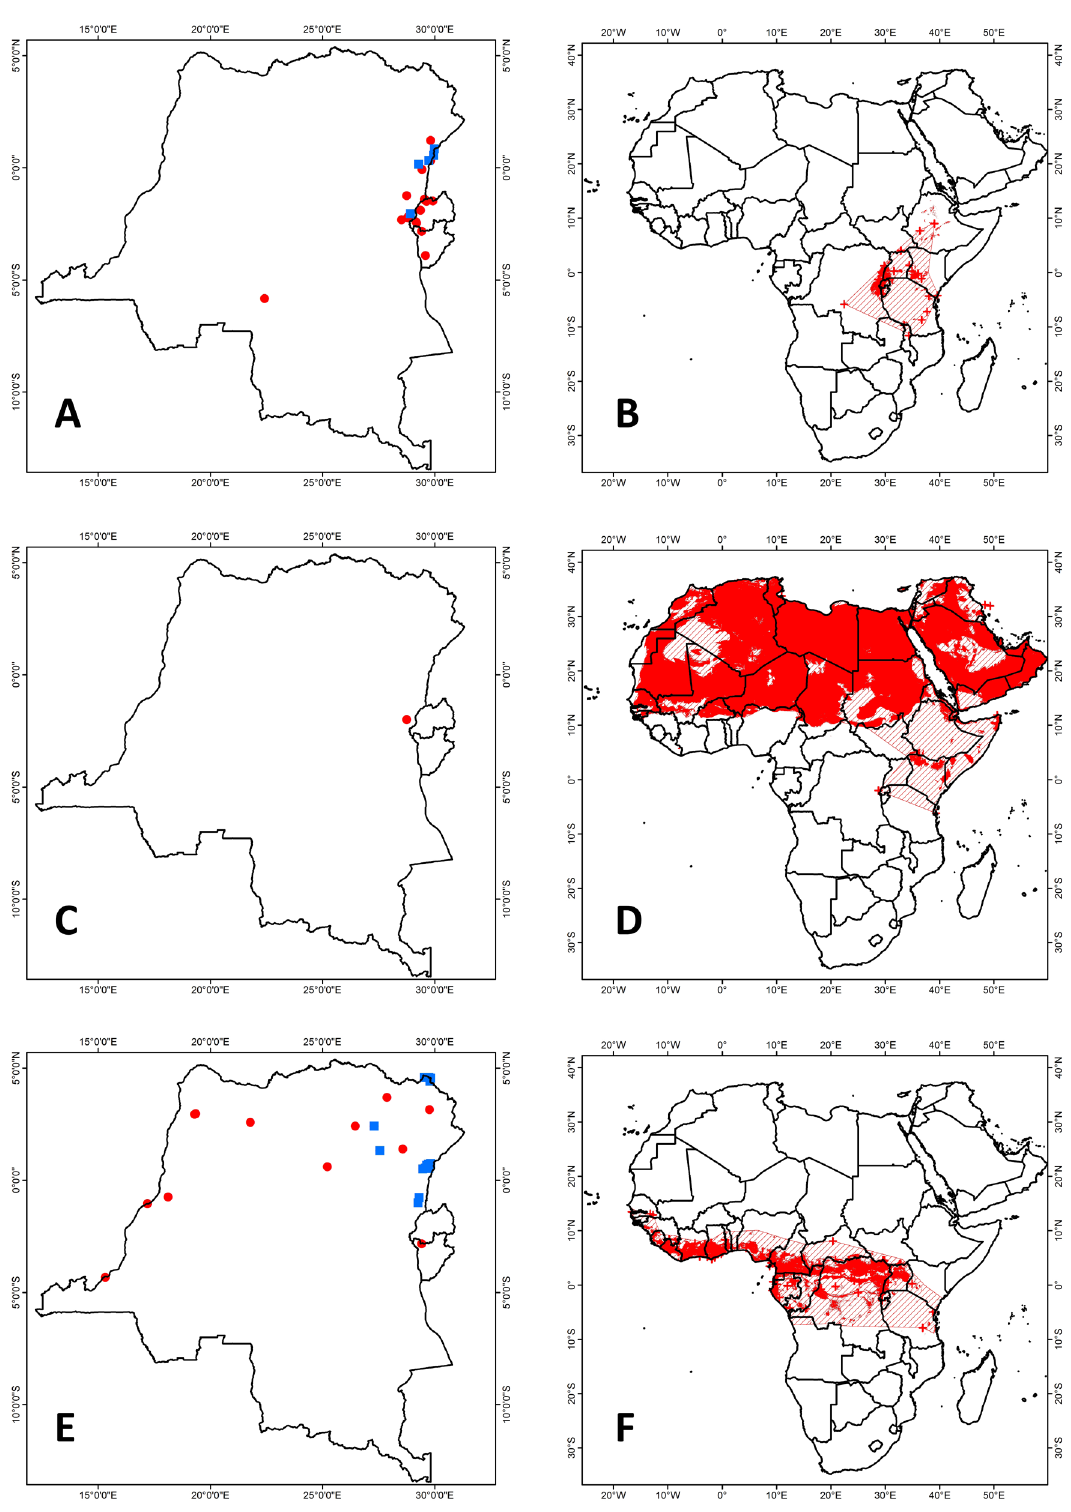
Fig. 10. Distribution maps. A–B . Stenonycteris lanosus Thomas, 1906. C–D . Asellia tridens (E. Geoffroy St.-Hilaire, 1813). E–F . Doryrhina cyclops (Temminck, 1853). A, C, E. Distribution in the CRB